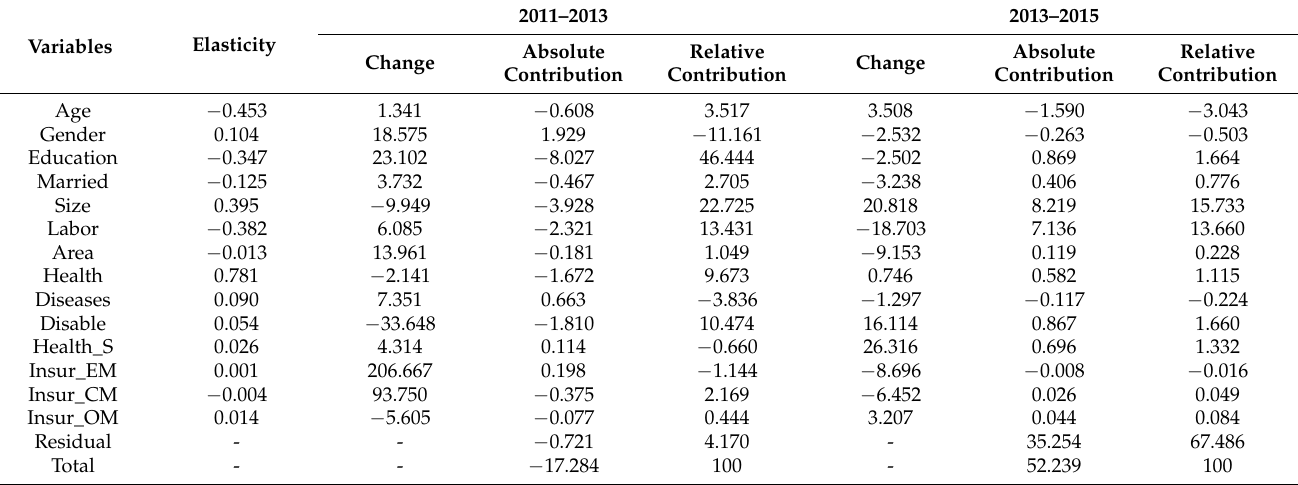
Table 8. Contribution of determinants to financial vulnerability changing for rural